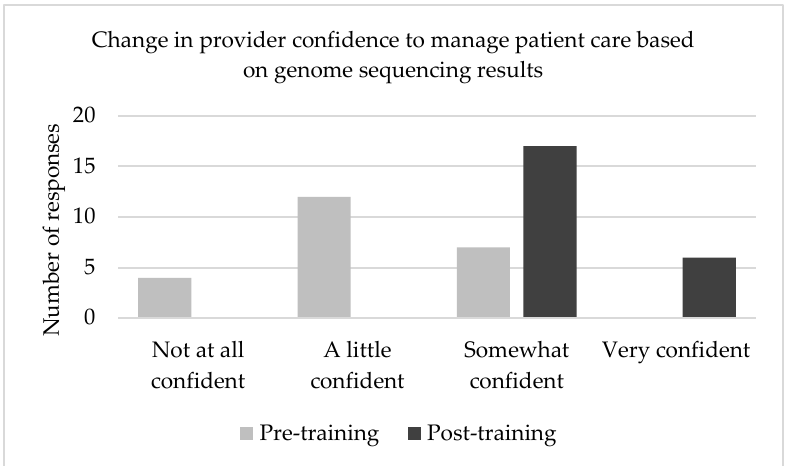
Figure 2. Comparison of self-reported provider confidence before and after participating in SouthSeq training about ability to read and interpret genome sequencing results.